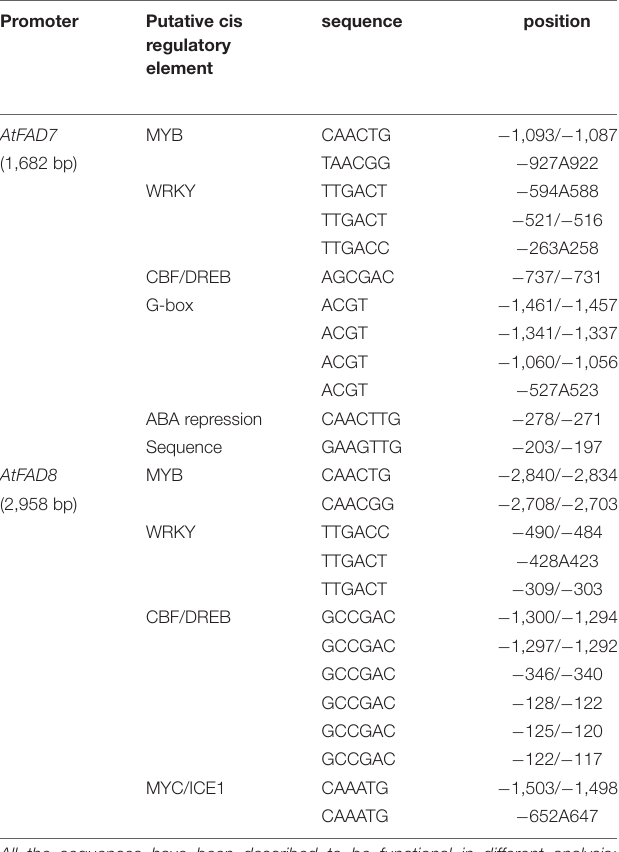
TABLE 1 | List and positions in the Arabidopsis thaliana AtFAD7 and AtFAD8 promoters of the different putative cis-regulatory elements identified in the in silico